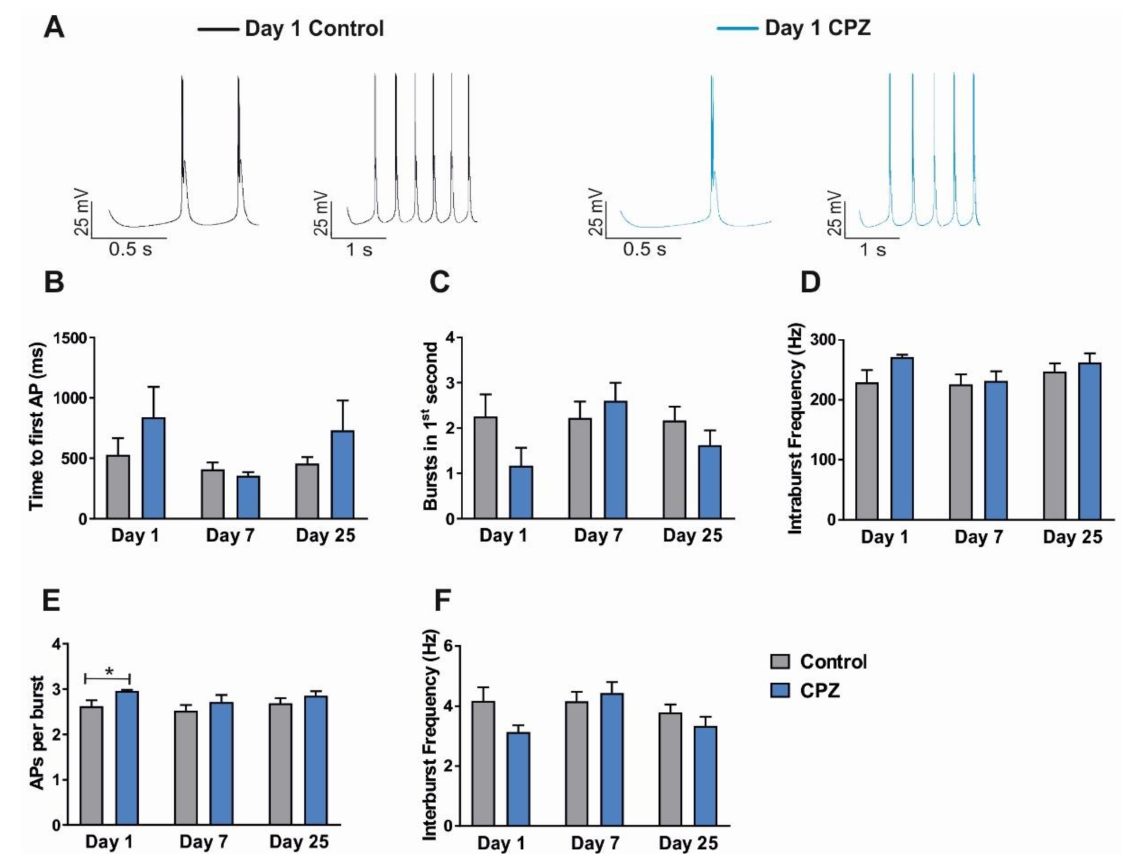
Figure 11. The NEURON-modeled influence of CPZ treatment on spontaneous burst activity of TC neurons. CPZ- treated mice (blue) after 1, 7, 25 days of remyelination and age-matched controls (grey) for each remyelination period. ( A ) Exemplary simulations of spontaneous burst activity of age matched controls and CPZ-treated mice on Day1 of remyelination. ( A – F ) The bar graphs displaying characteristics of bursting: time to first action potential ( B ), bursts within the first second of the simulation ( C ), intraburst frequency ( D ), action potentials per burst ( E ), and the interburst frequency ( F ). * indicates p values less than